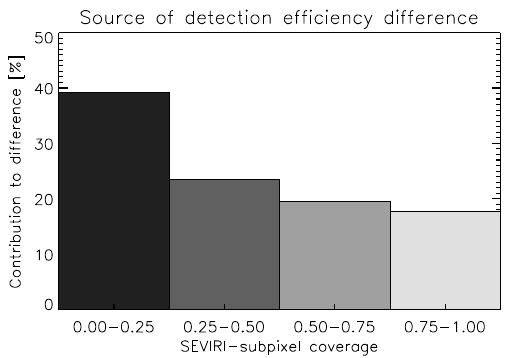
Fig. 10. Contribution of subpixel effects to the observed differences between MeCiDA2 and MoCiDA2.